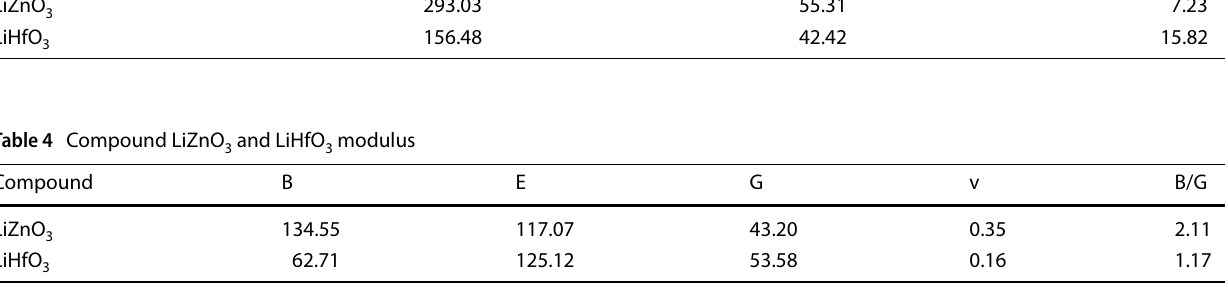
Table 3 Elastic constants of LiZnO Compound